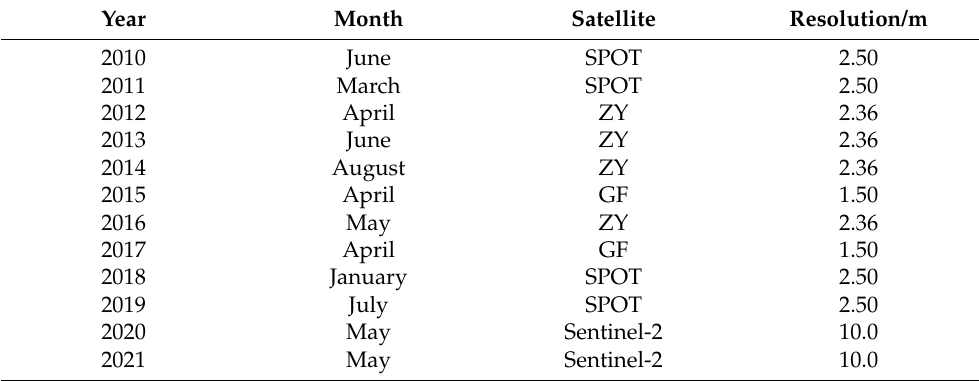
Table 1. Time, source and resolution of high-resolution remote sensing images.